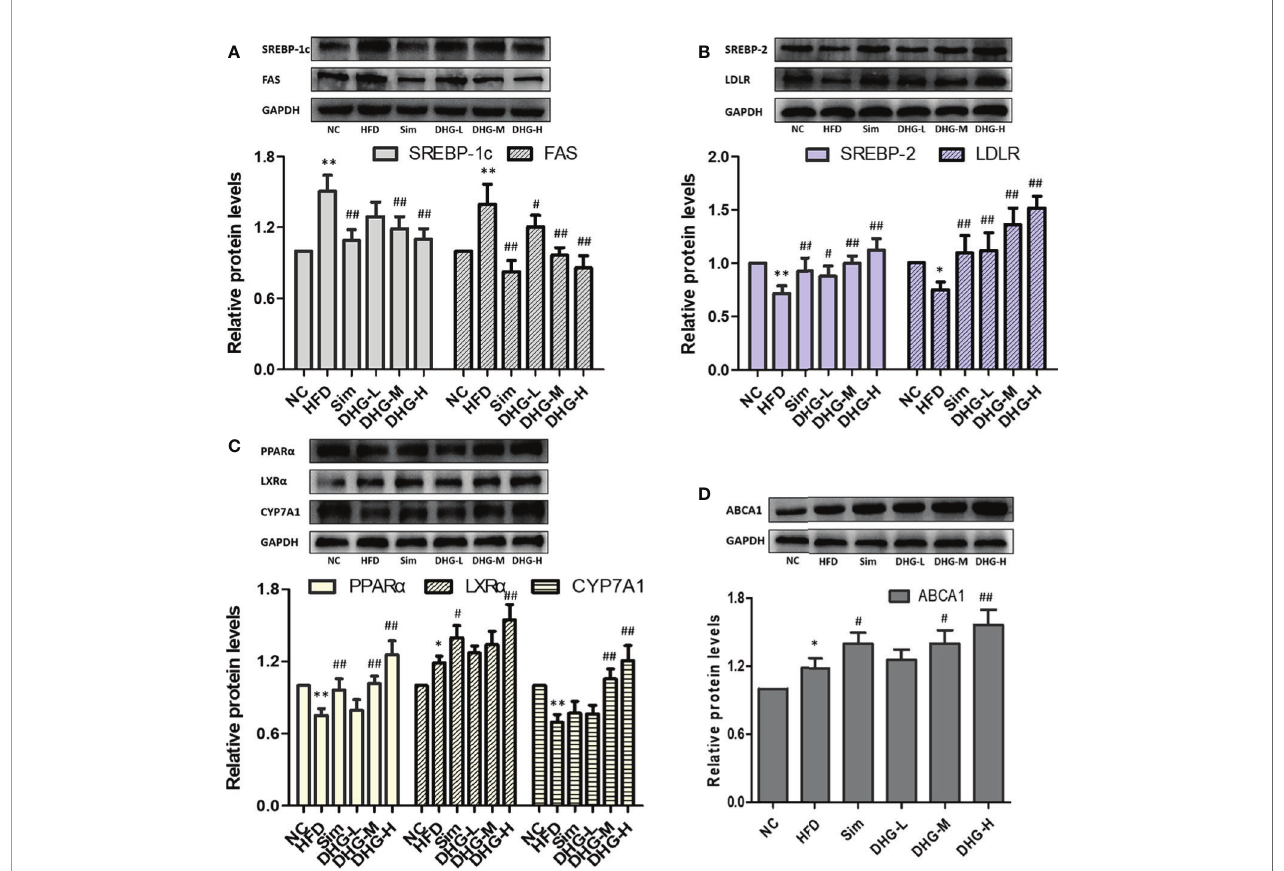
FIGURE 7 | Effect of DHG on protein expression of targets in hamster liver by Western blot. Values are mean ± SD, n = 3. (A) SREBP-1c, FAS. (B) SREBP-2, LDLR. (C) PPAR a , LXR a , CYP7A1. (D) ABCA1. * p < 0.05, ** p < 0.01 vs NC group; # p < 0.05, ## p < 0.01 vs HFD group. The expression levels were normalized by